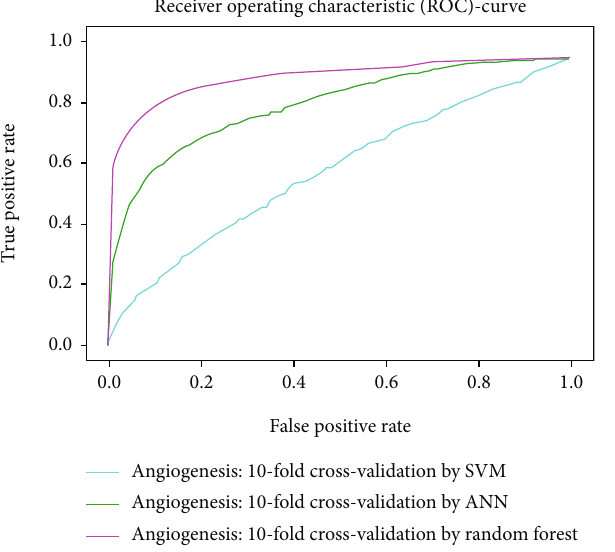
Figure 8: Comparison based on 10-folds.